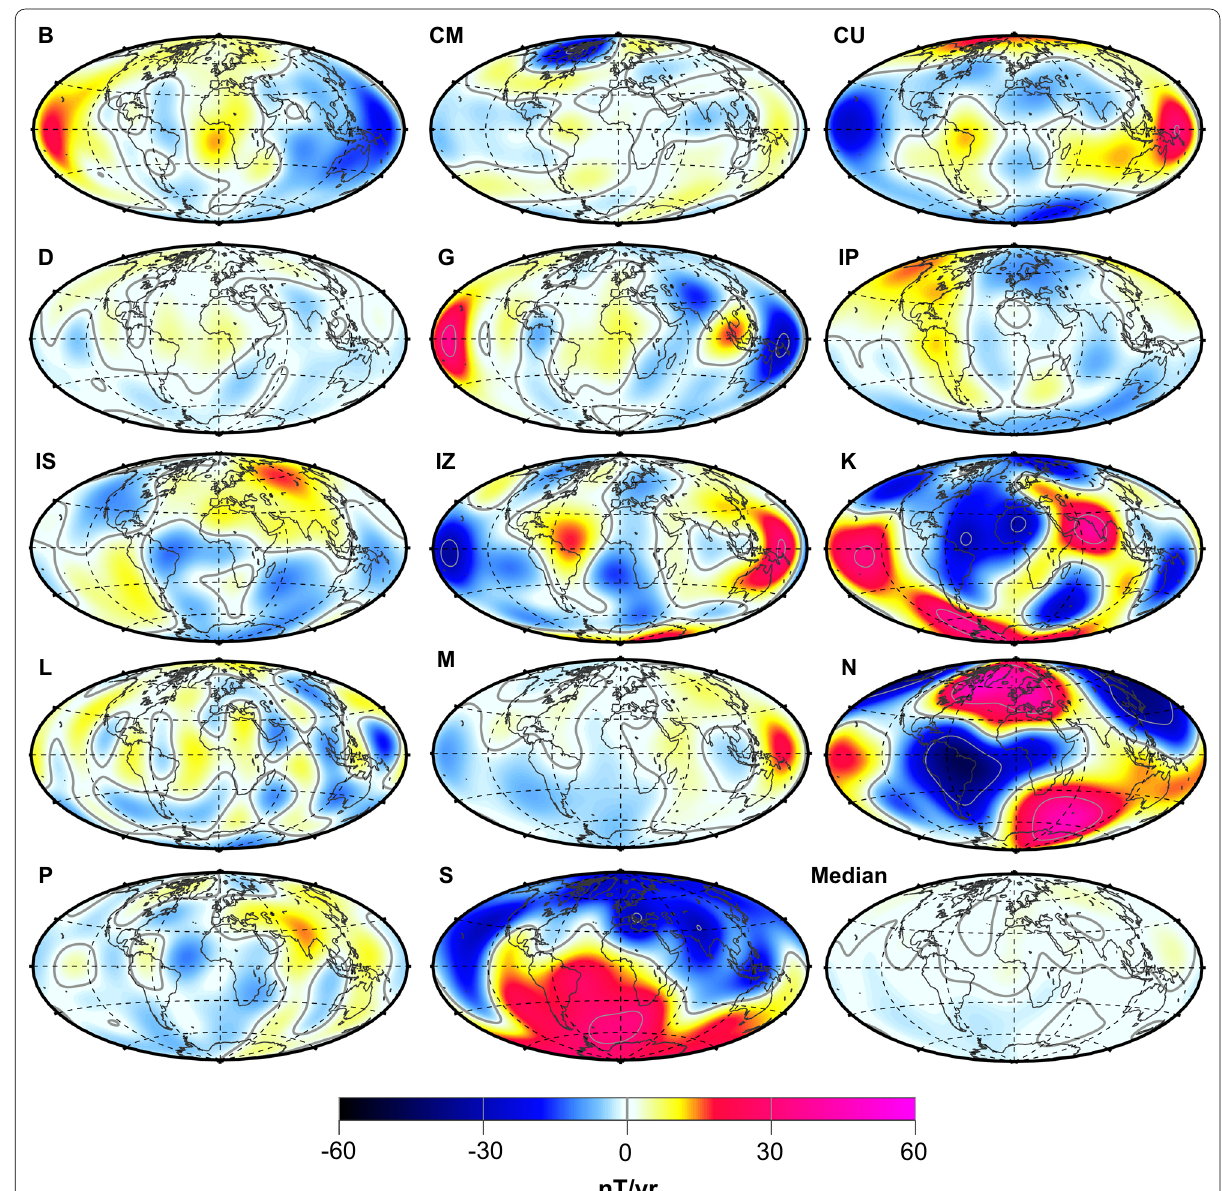
a between the vertical field ( d B z / d t ) of the SV-2020-2025 candidates =